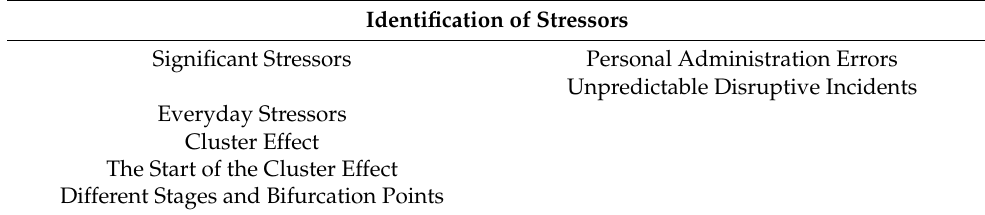
Table 1. A summary of qualitative results from the video diaries and focus groups (part 1).